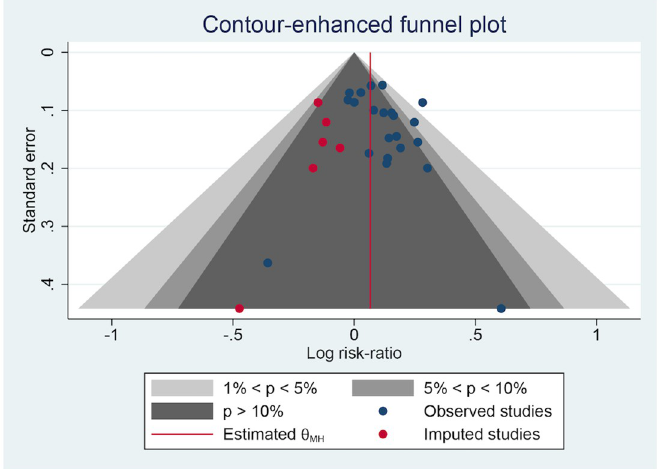
Fig 11. The contour-enhanced plot of the DCR.